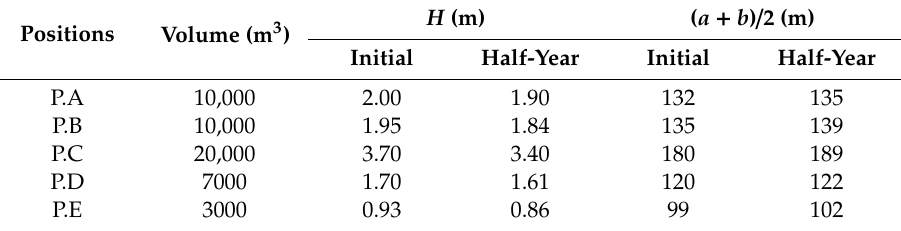
Table 4. Long-term morphology changes of the mound at five